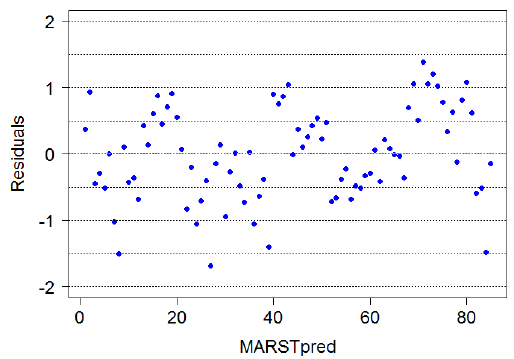
Figure 7. Residuals of the predicted MARST.